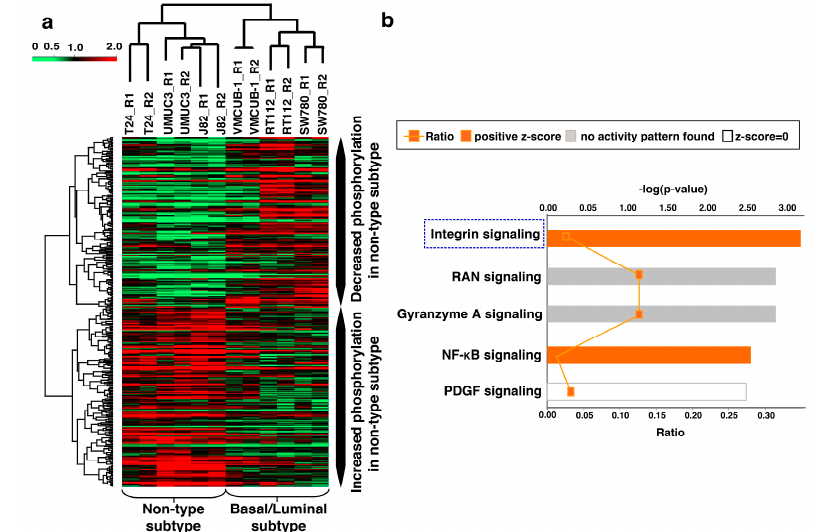
Figure 4. ( a ) Supervised clustering of the molecular subtypes of bladder carcinoma cell lines. A t -test conducted on the quantified data (across all cell lines) indicated that 375 peptides (corresponding to 289 proteins) were differentially phosphorylated in the non-type cell lines (T24, J82, and UMUC3) as compared with the luminal/basal subtype (SW780, RT112, and VMCUB-1) ( p ≤ 0.05). ( b ) Canonical pathways enriched in the non-type subtype of bladder carcinoma. IPA analysis identified the “integrin pathway” as the most significantly enriched pathway in the aggressive non-type bladder carcinoma subtype.